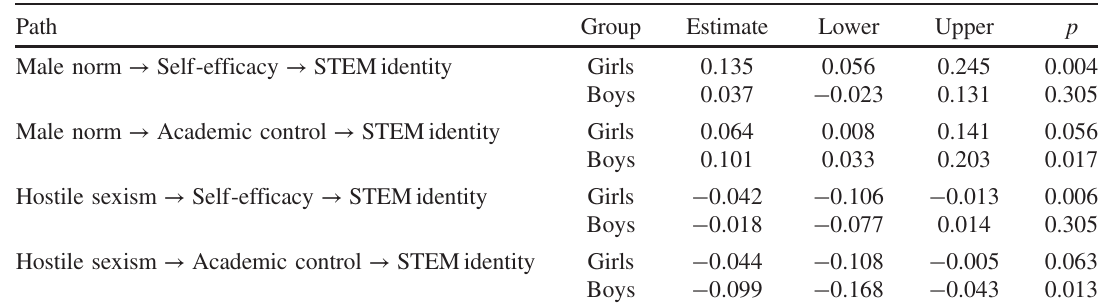
TABLE V. Unstandardized indirect effects of the gender stereotypes on disciplinary identity for girls and boys. Path